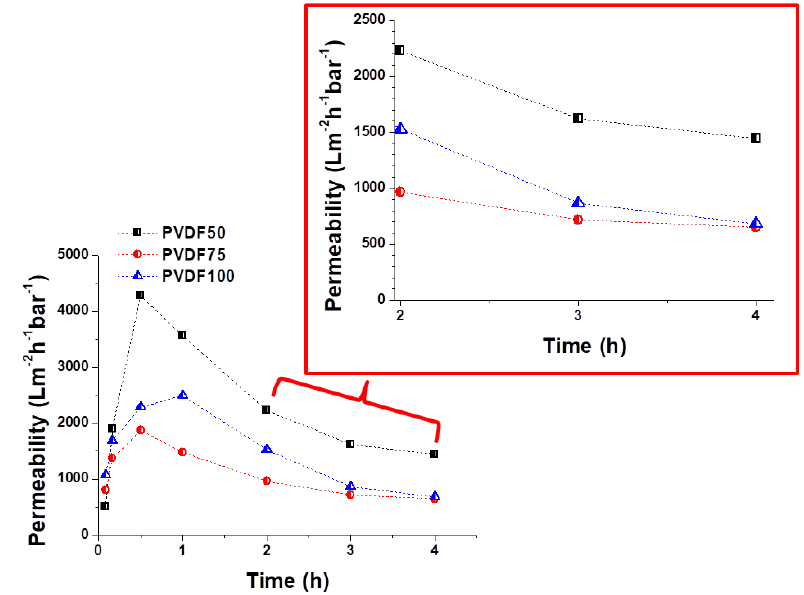
Figure 14. Permeability of PVDF multilayer nanofibrous membranes at various laminating pressures over time.